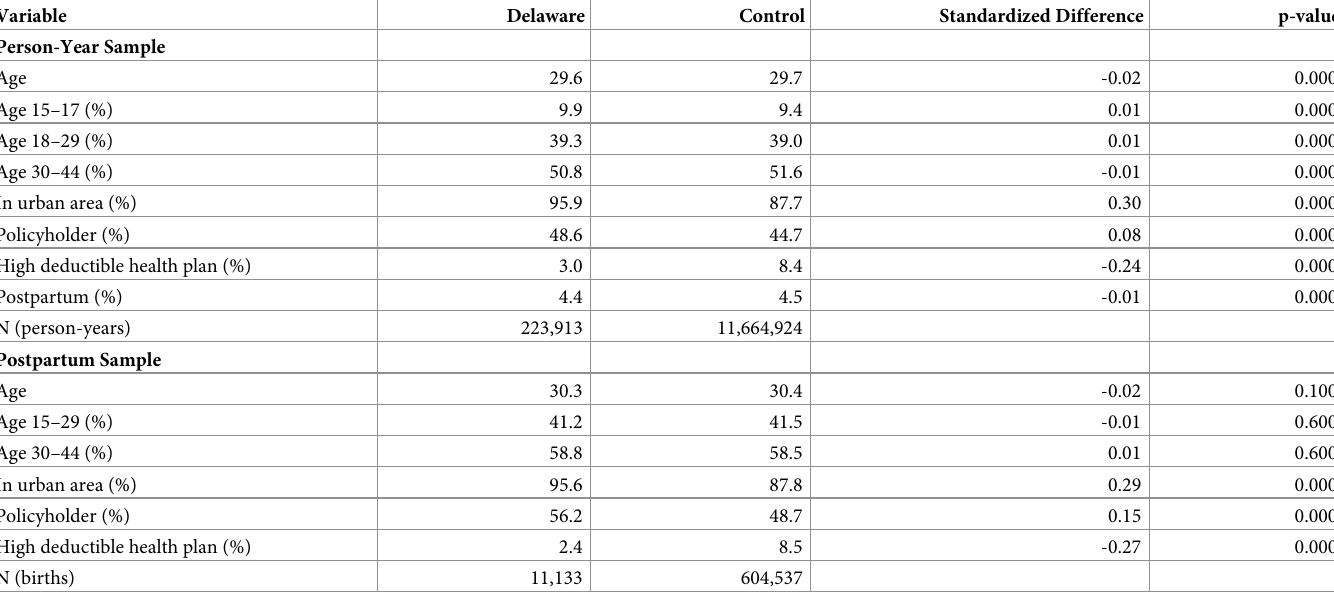
Table 1. Summary statistics for women age 15–44 in delaware and control states,